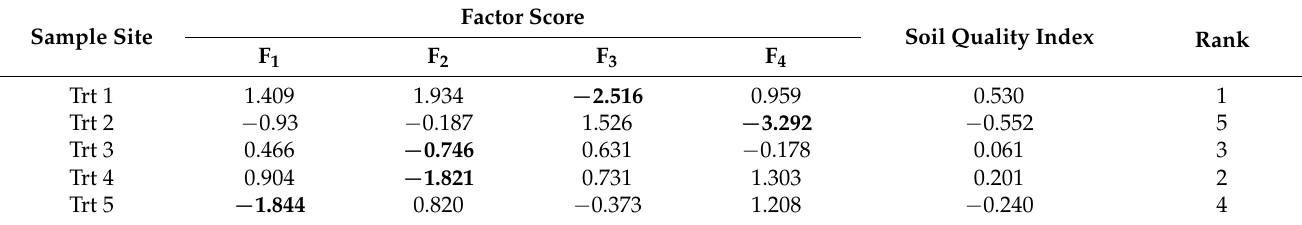
Table 6. Factor scores of leaf functional traits of Z. planispinum .